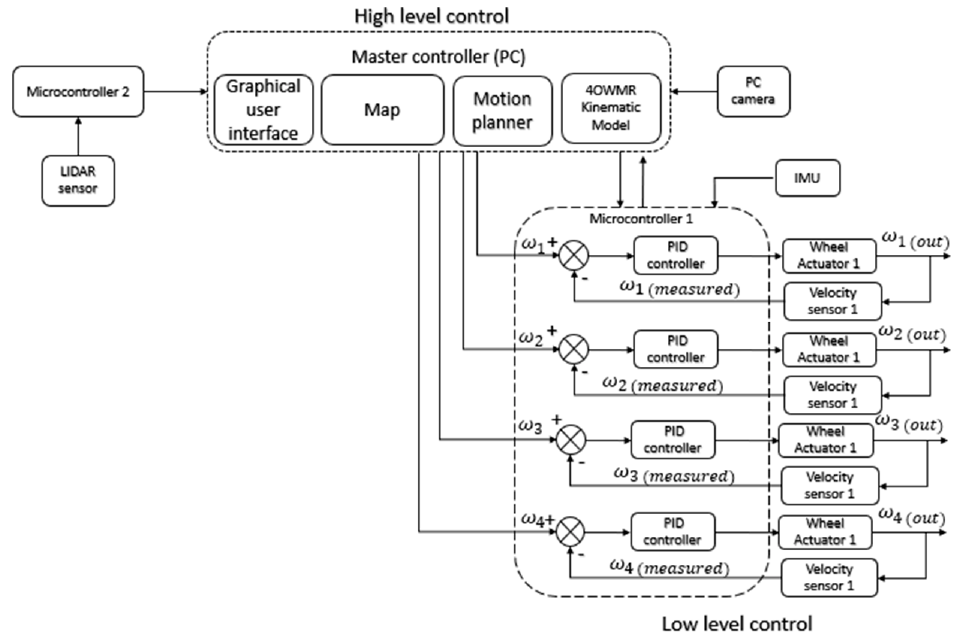
Figure 2. Schematic overview of 4OWMR control stages.